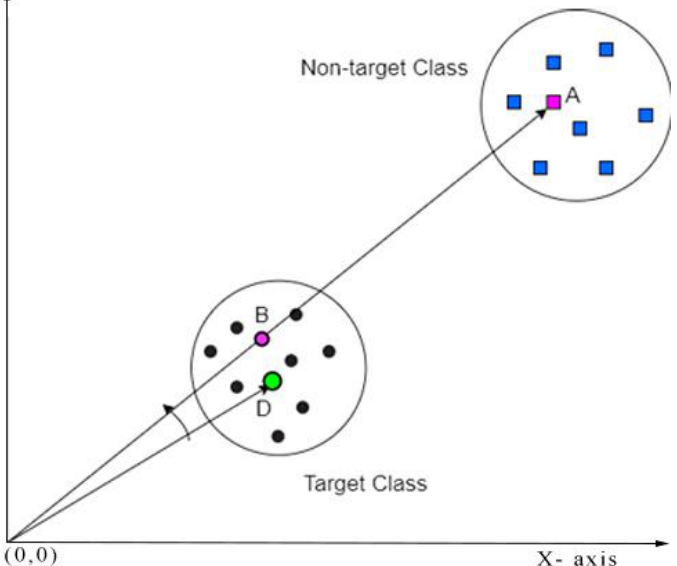
Figure 3. The problem in angle measurement for datapoint having different vector position but same direction with respect to the origin.